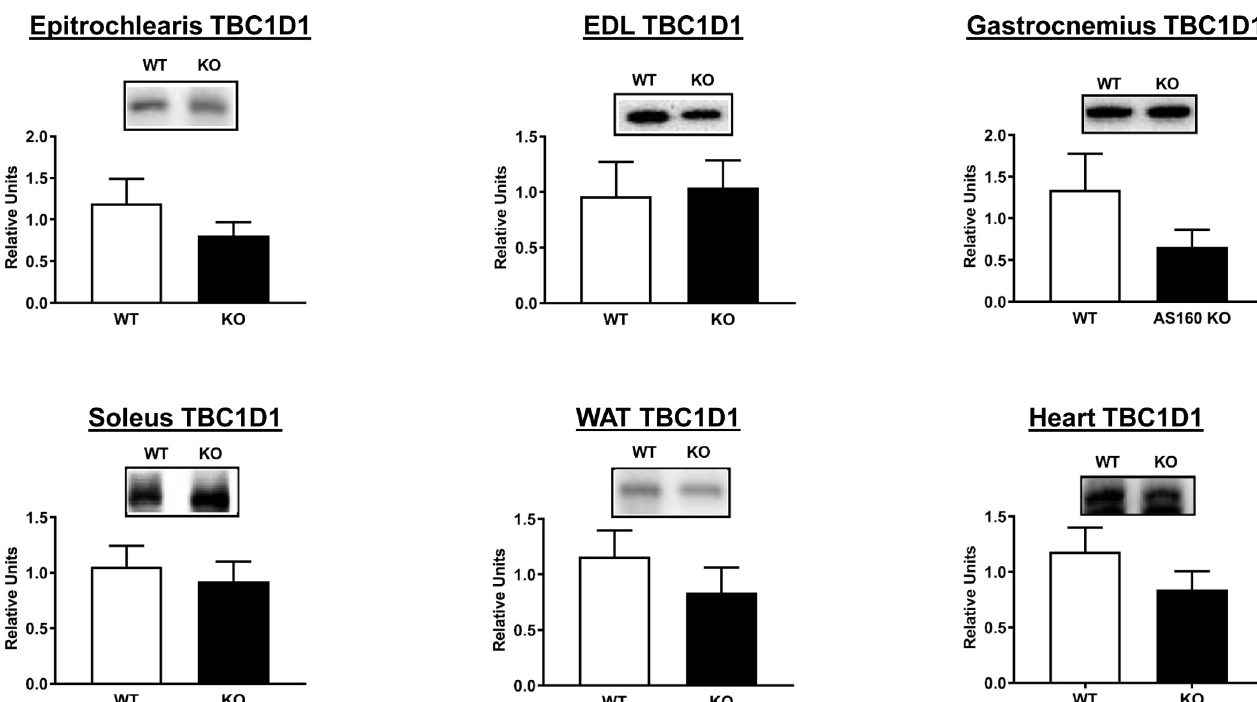
Fig 5. TBC1D1 abundance in tissues from WT (white bars) and KO (black bars) animals subjected to the HEC. Extensor digitorum longus = EDL. White adipose tissue = WAT. Means ± SEM for 6 rats of each genotype.